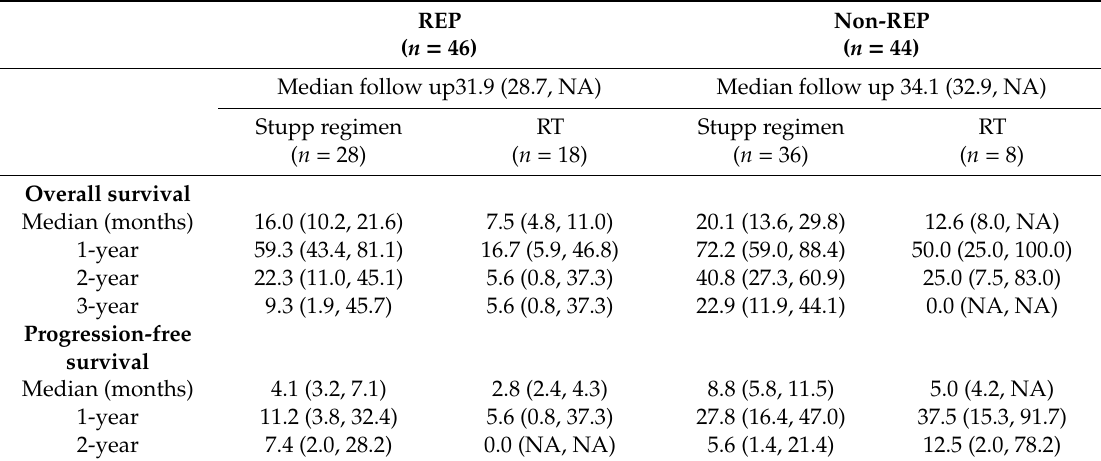
Figure 4. Survival outcomes of patients with REP and non-REP in relation to the treatment. Table 3. Survival outcomes in patients with REP and non-REP in relation to the treatment.